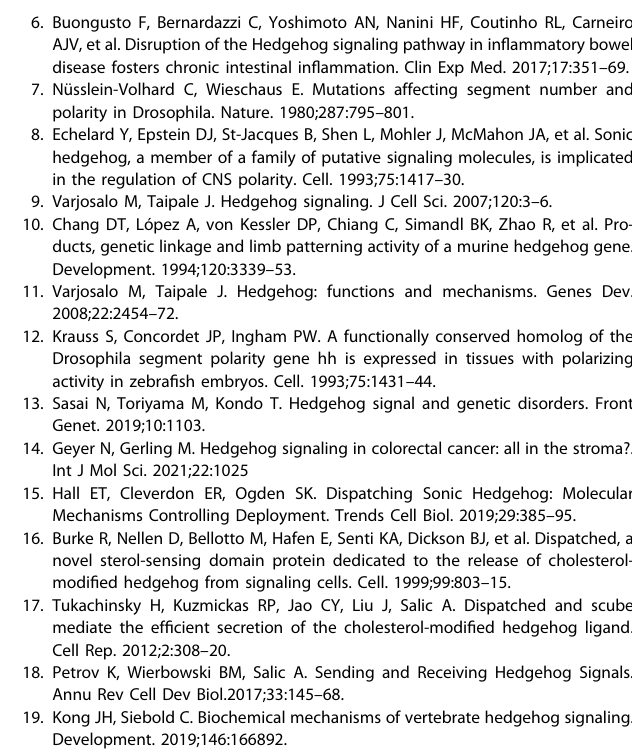
Fig. 4 Activation of stromal Hh signalling reduces tumour burden and CAC progression. Activation of stromal Hh signalling inhibits the initiation and progression of CAC by increasing stromal anti-in fl ammatory cytokine IL-10 and CD4 + Foxp3 + regulatory T cells. The Hh activator SAG21k can decrease colitis severity and CAC burden. Administration of the Hh antagonist, vismodegib, can facilitate CAC formation. Additionally, activated stromal Hh signalling reduces the tumour burden and tumour progression in mouse CAC models partly by reducing secreted BMP inhibitors such as Gremlin 1 (Grem1) and Noggin (Nog), and by restricting cancer stem cell (CSC) features. Arrows and blunt- ended lines indicate activation and inhibition, respectively. Hh Hedgehog, IL-10 interleukin-10, Nog Noggin, Grem1 Gremlin, BMP bone morphogenetic